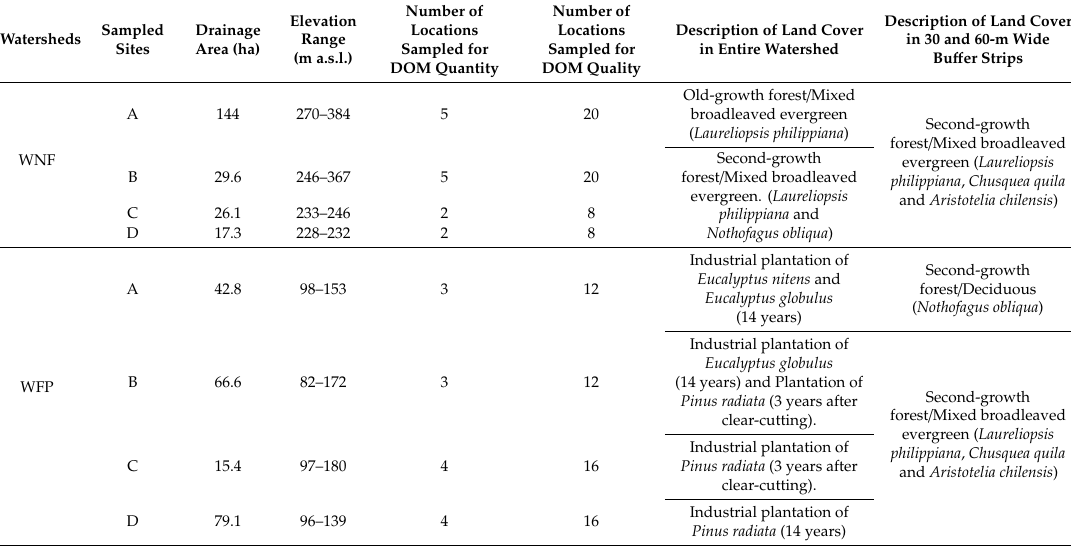
Table 1. Characteristics of watersheds dominated by native forests (WNF), forest plantations (WFP) and agricultural lands (WAL) according to sampled sites, elevation range, number of sampled locations of DOM (Dissolved Organic Matter) and description of the land